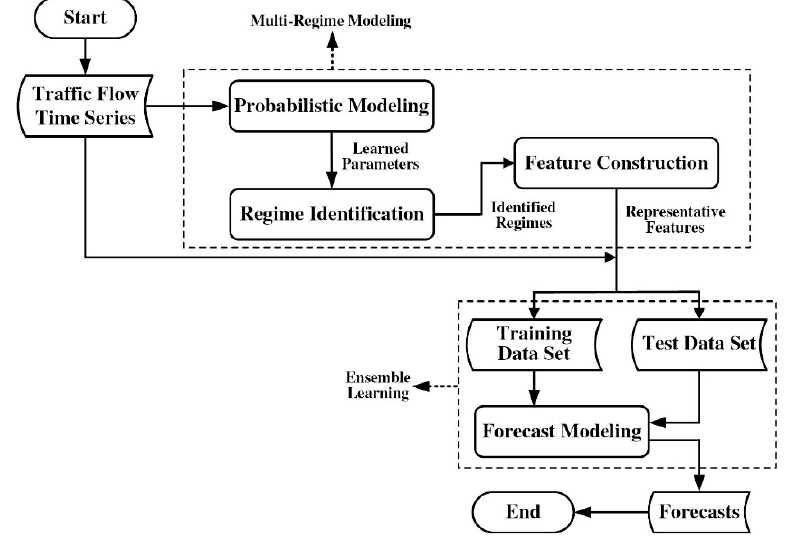
Figure 1. Overall framework of the proposed approach.